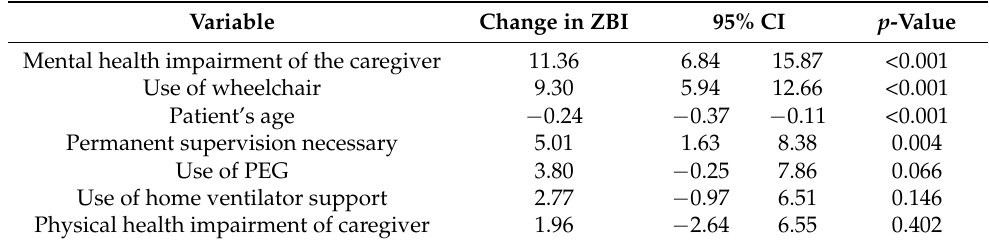
Table 3. Influencing factors on caregiver burden (ZBI score): The ZBI score constituted the dependent variable and patient-related as well as caregiver-related parameters were analyzed as possibly influencing independent variables. This multiple linear regression analysis showed a statistically significant influence of the CG’s mental health impairment, patient’s wheelchair use, patient’s age, and the necessity of permanent attendance of a helper/supervisor on the ZBI score. The model was adjusted for statistical outliers. The results are arranged by p -values. Abbreviations: ZBI = Zarit Burden Interview; CI = confidence interval; PEG = percutaneous endoscopic gastrostomy. Variable Change in ZBI 95% CI